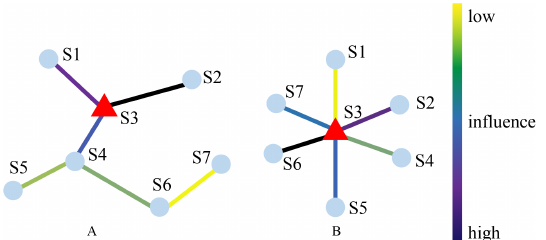
Figure 4. Static and dynamic links between nodes. Subfigure ( A ) shows the static graph calculated by node distances. Subfigure ( B ) shows the dynamic graph calculated by similarity of traffic patterns.